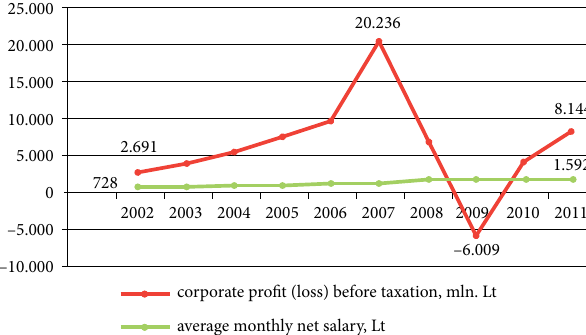
Fig. 2. Changes of corporate profit before taxation (mln. LT) and average net salary in Lithuania in 2002–2011 (Source: Statistics of Lithuania and authorial